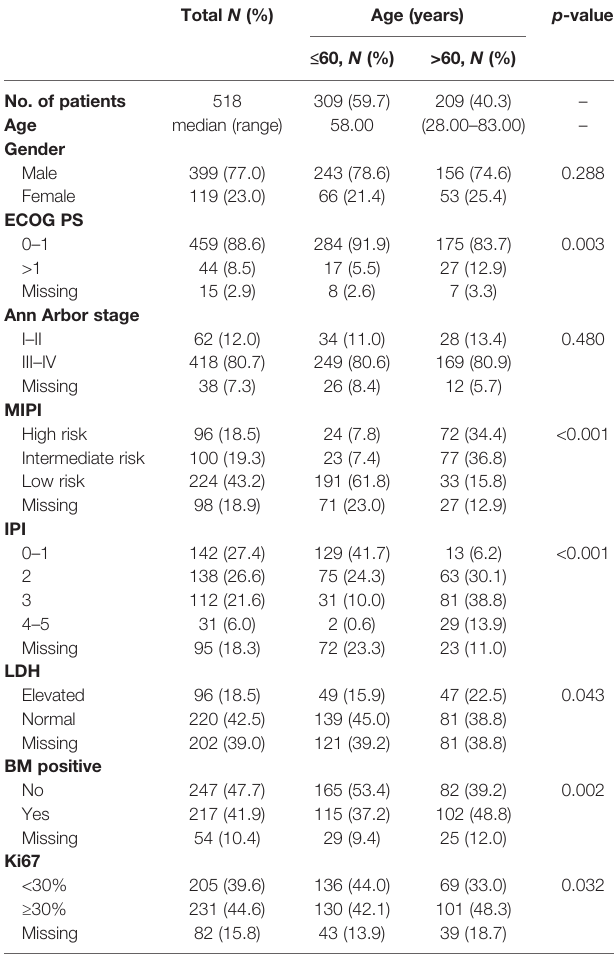
TABLE 1 | Patient characteristics in different age